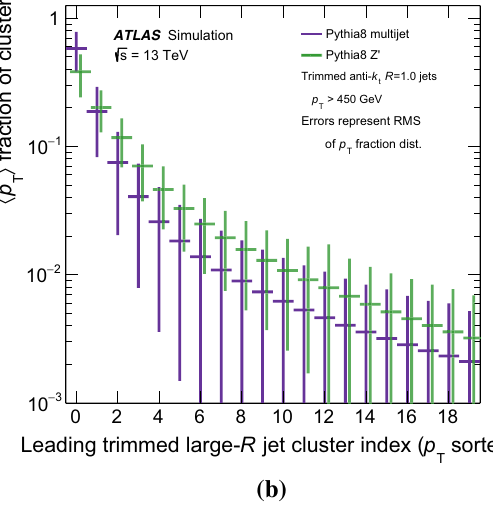
Fig. 6 The distribution of the fraction of p T carried by the highest- p T cluster (Cluster 0) along with the next-highest (Cluster 1), third-highest (Cluster 2), and tenth-highest- p T (Cluster 9) clusters ( a ) along with the average value of the ratio of the cluster p T to the jet p T for the 20 highest- p T clusters ( b ). The dashed lines in a show distributions for signal jets, and the full lines show distributions for background jets. The vertical lines on each point in b represent the RMS of the corresponding